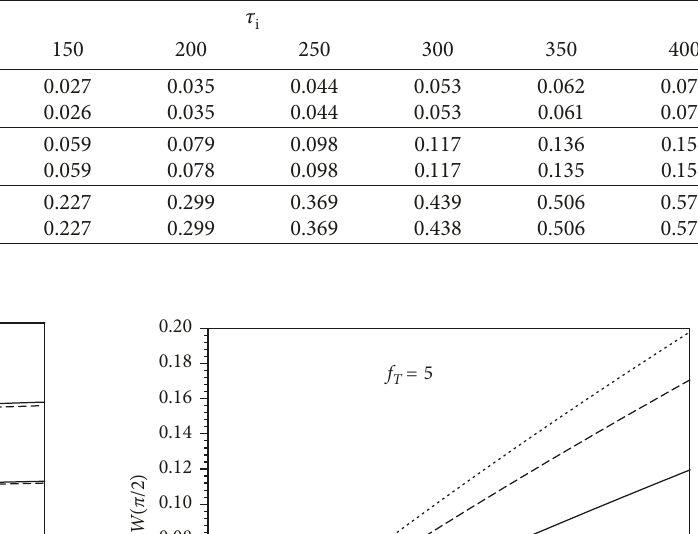
π /2 of Al semicircular curved beam with two ends clamped under uniform temperature rise ( )